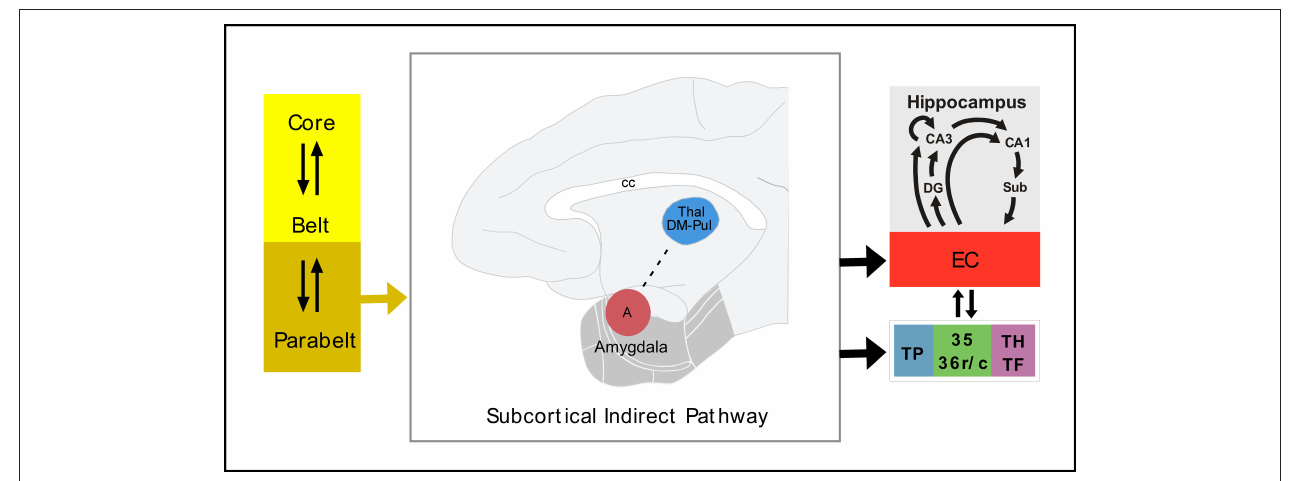
Figure 4 | Possible subcortical indirect pathway for auditory input to the medial temporal memory system. See list of